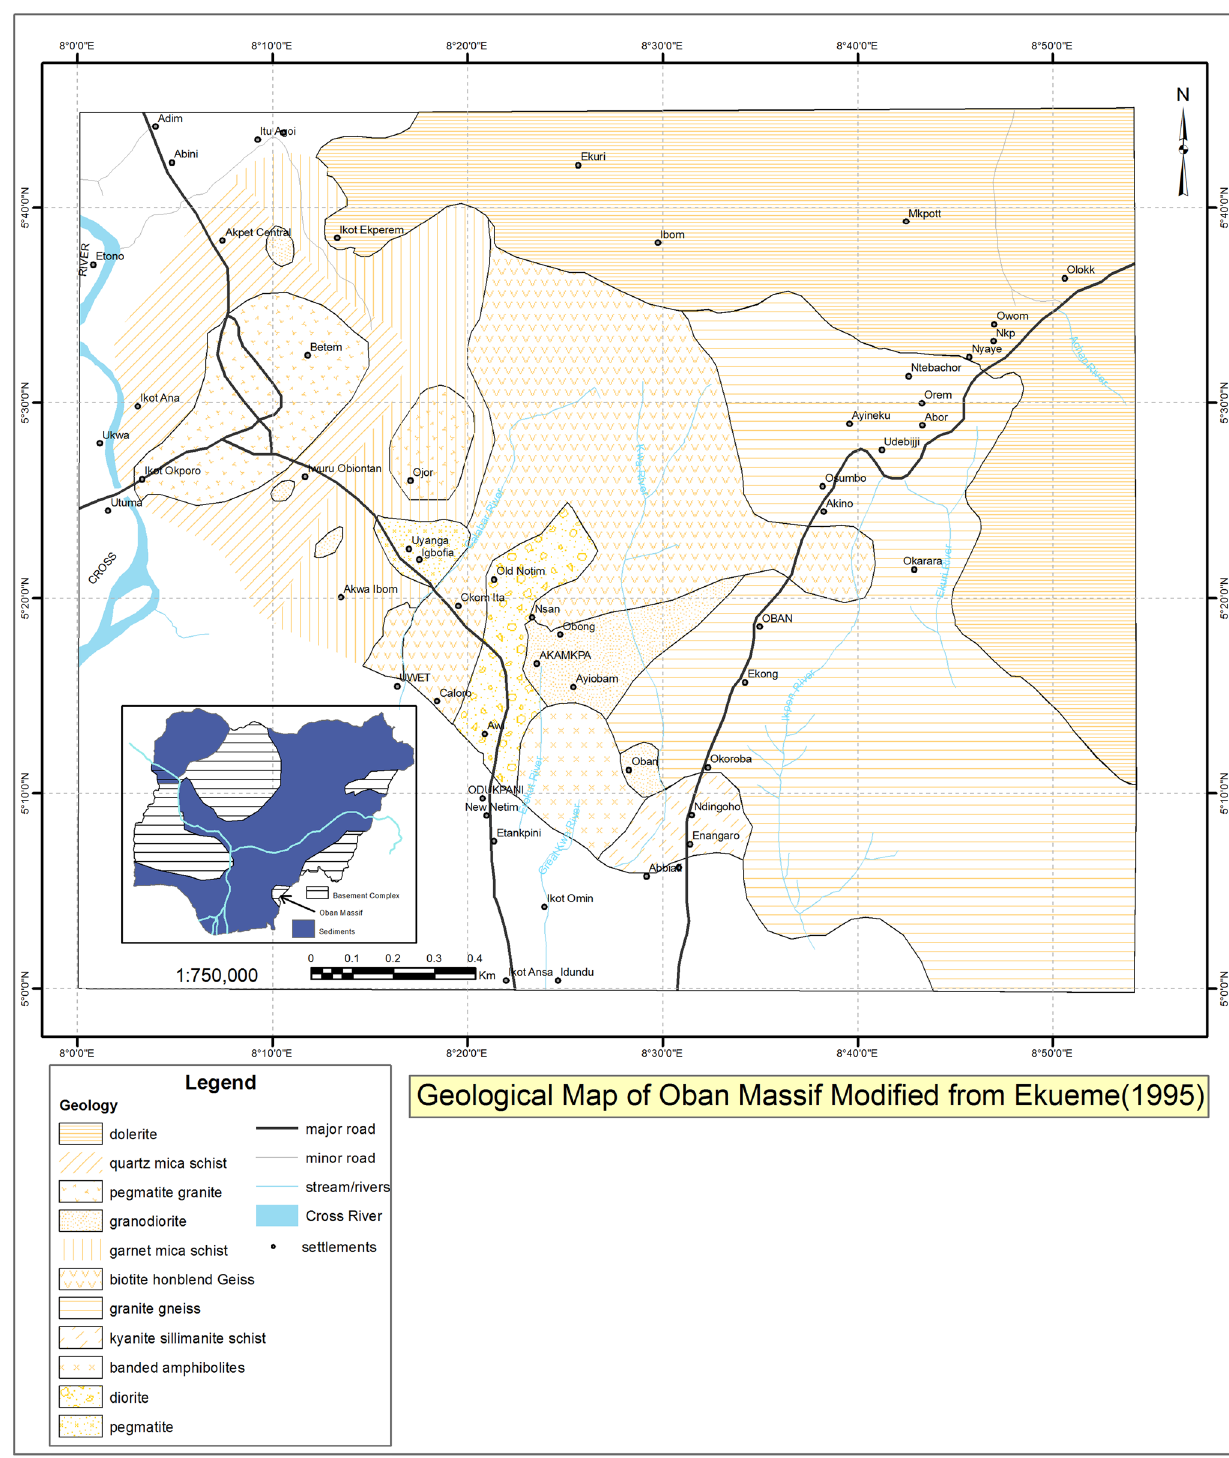
Fig. 2 Geological map of the study